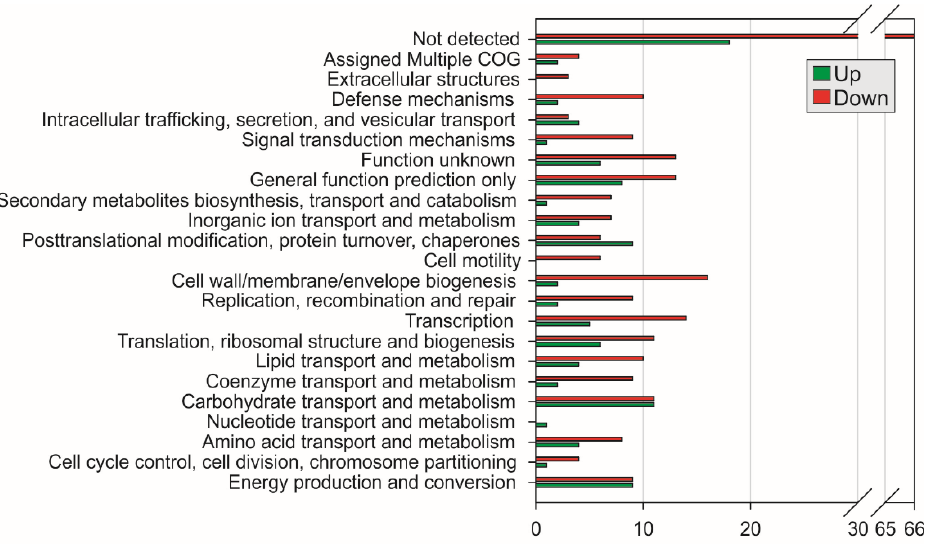
Figure 1. Functional classification of differentially expressed genes according to GO.